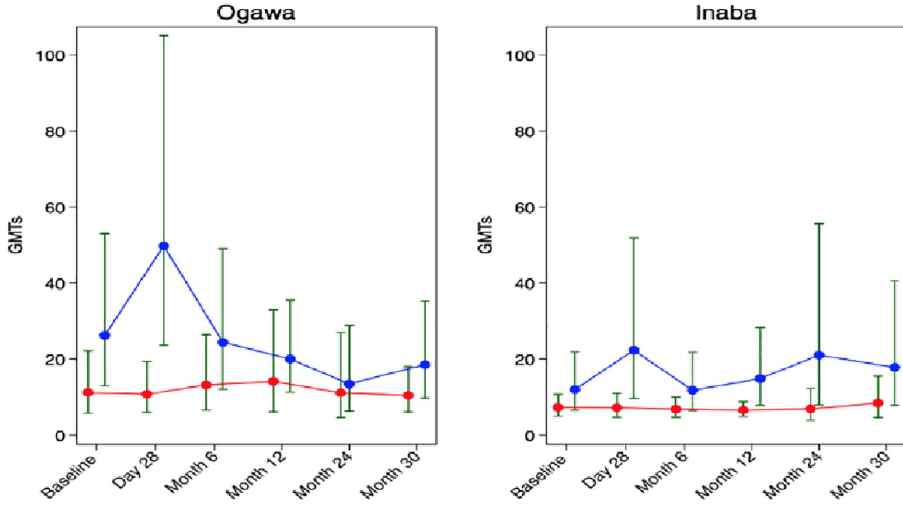
Fig 2. Kinetics of vibriocidal geometric mean titers (95% CI) against Ogawa and Inaba by HIV status. Red dots indicate HIV + participants and blue dots HIV- participants.